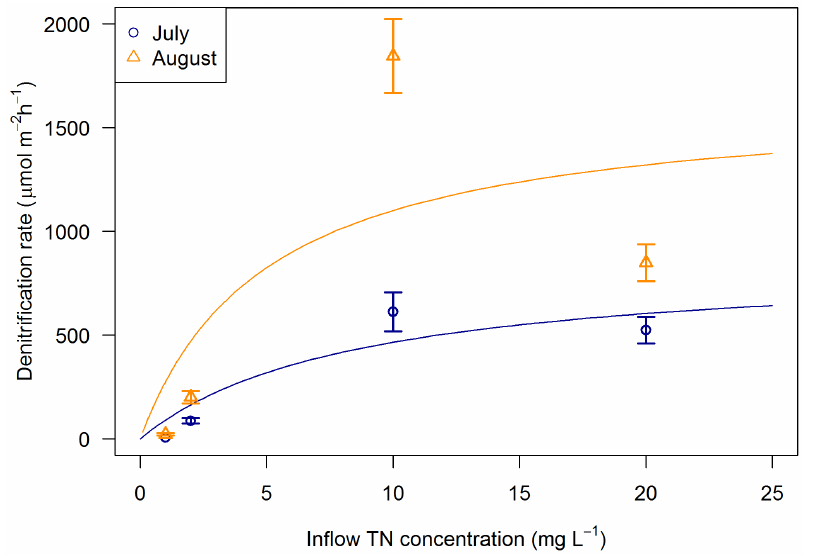
Figure 3. Rates of denitrification ( 14 N + 15 N) against inflow TN concentration. Measured in the influent concentration experiment ( 6 standard error (n=4)) during July and August. Michaelis-Menten curves were fitted to give V max =861 m mol m 2 2 h 2 1 and K m =8.46 mg L 2 1 in July